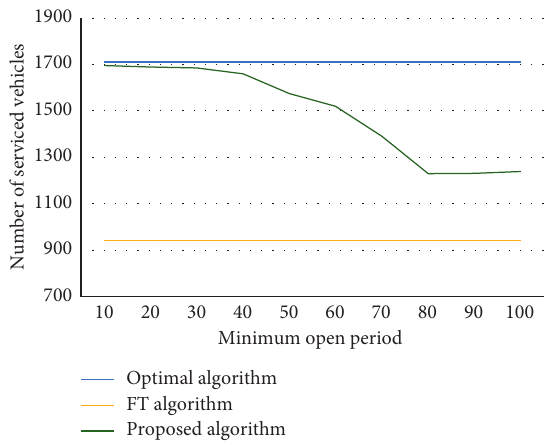
Figure 17: Effect of changing the minimum open period or the fixed green period in the FT algorithm on the number of serviced vehicles using the OA, FT, and PA algorithms.